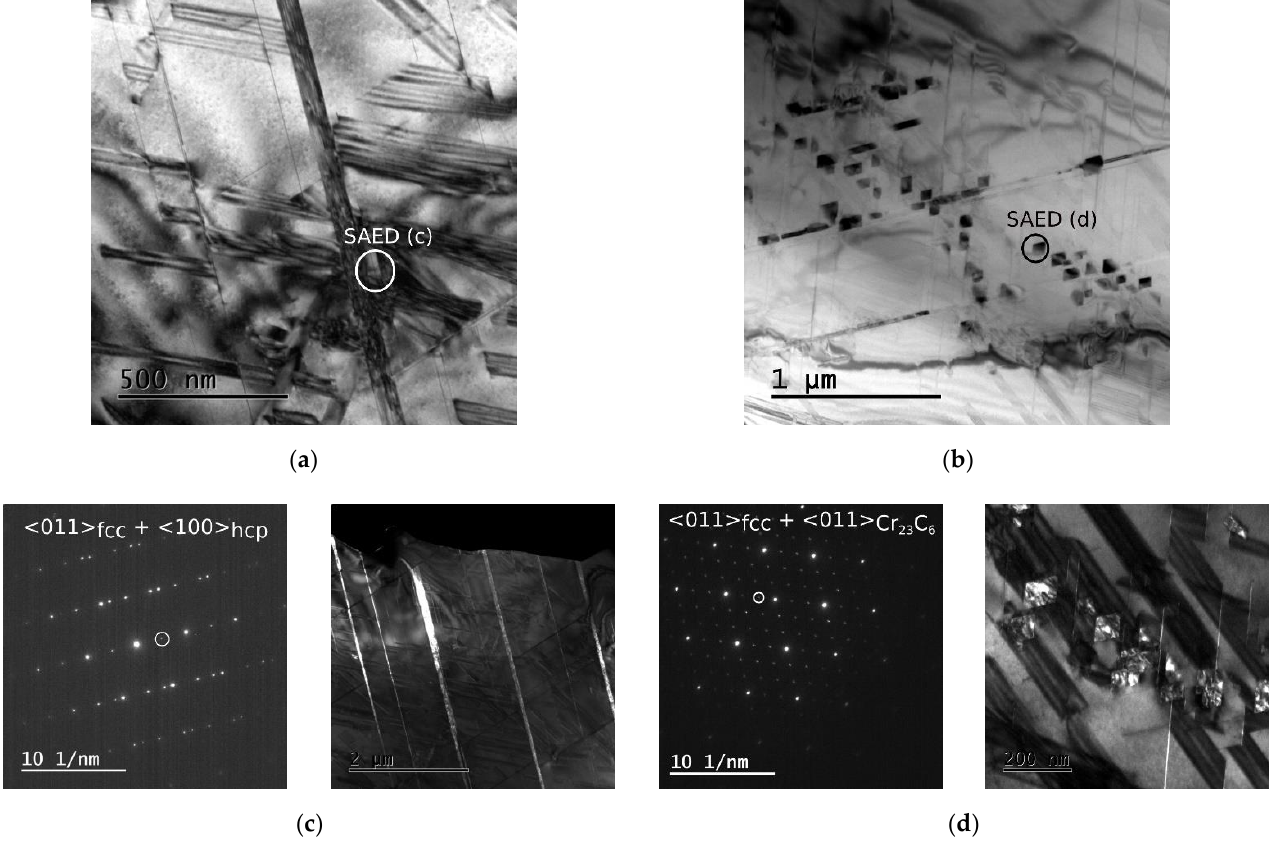
Figure 13. Microstructure of the cast alloy after 1200 °C/2 h + 800 °C/7 h heat treatment: ( a ) TEM image of the matrix; ( b ) TEM image of carbidic precipitates; ( c , d ) diffraction pattern with dark field image based on a selected diffraction point.